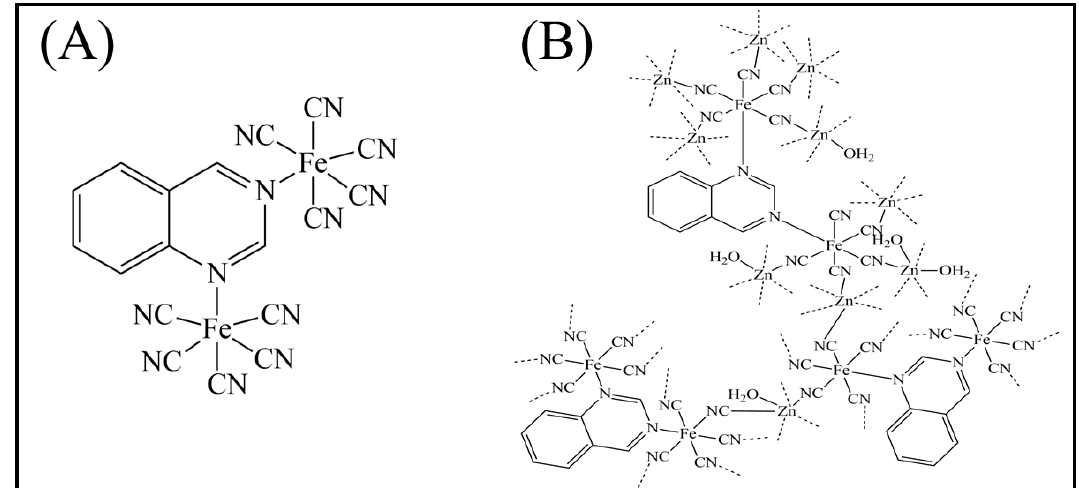
Figure 1. Structures of ( A ) pentacyanidoferrate with quinazoline ligand (PCF-qnz) and ( B ) Prussian blue analogue derivative from quinazoline ligand and zinc(II) (PBA-qnz).